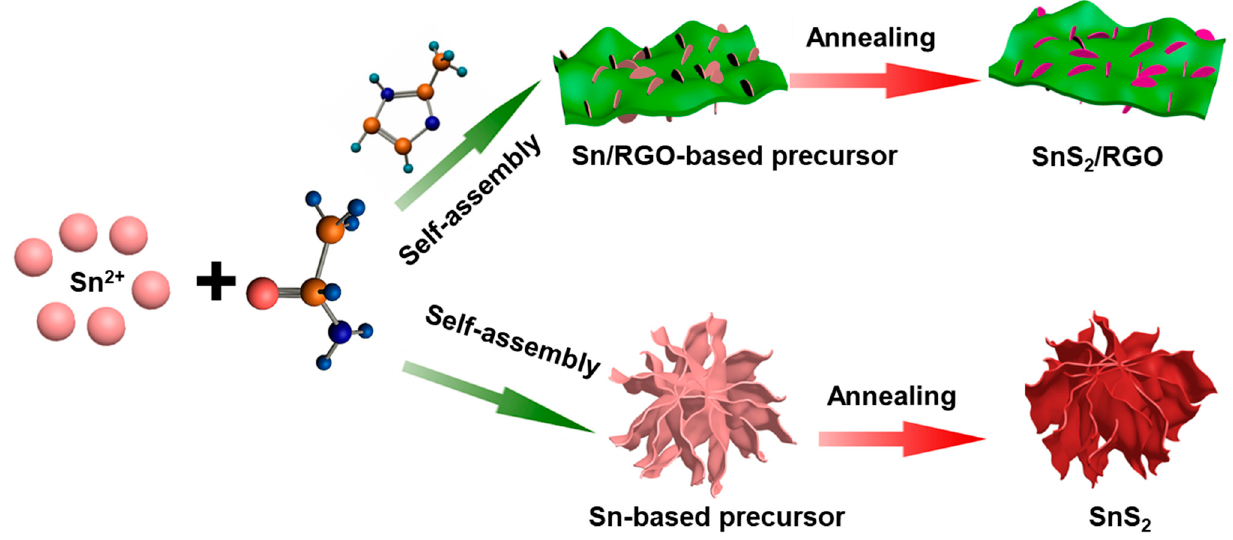
Figure 1. Schematic illustration of the formation process of pure SnS 2 , and SnS 2